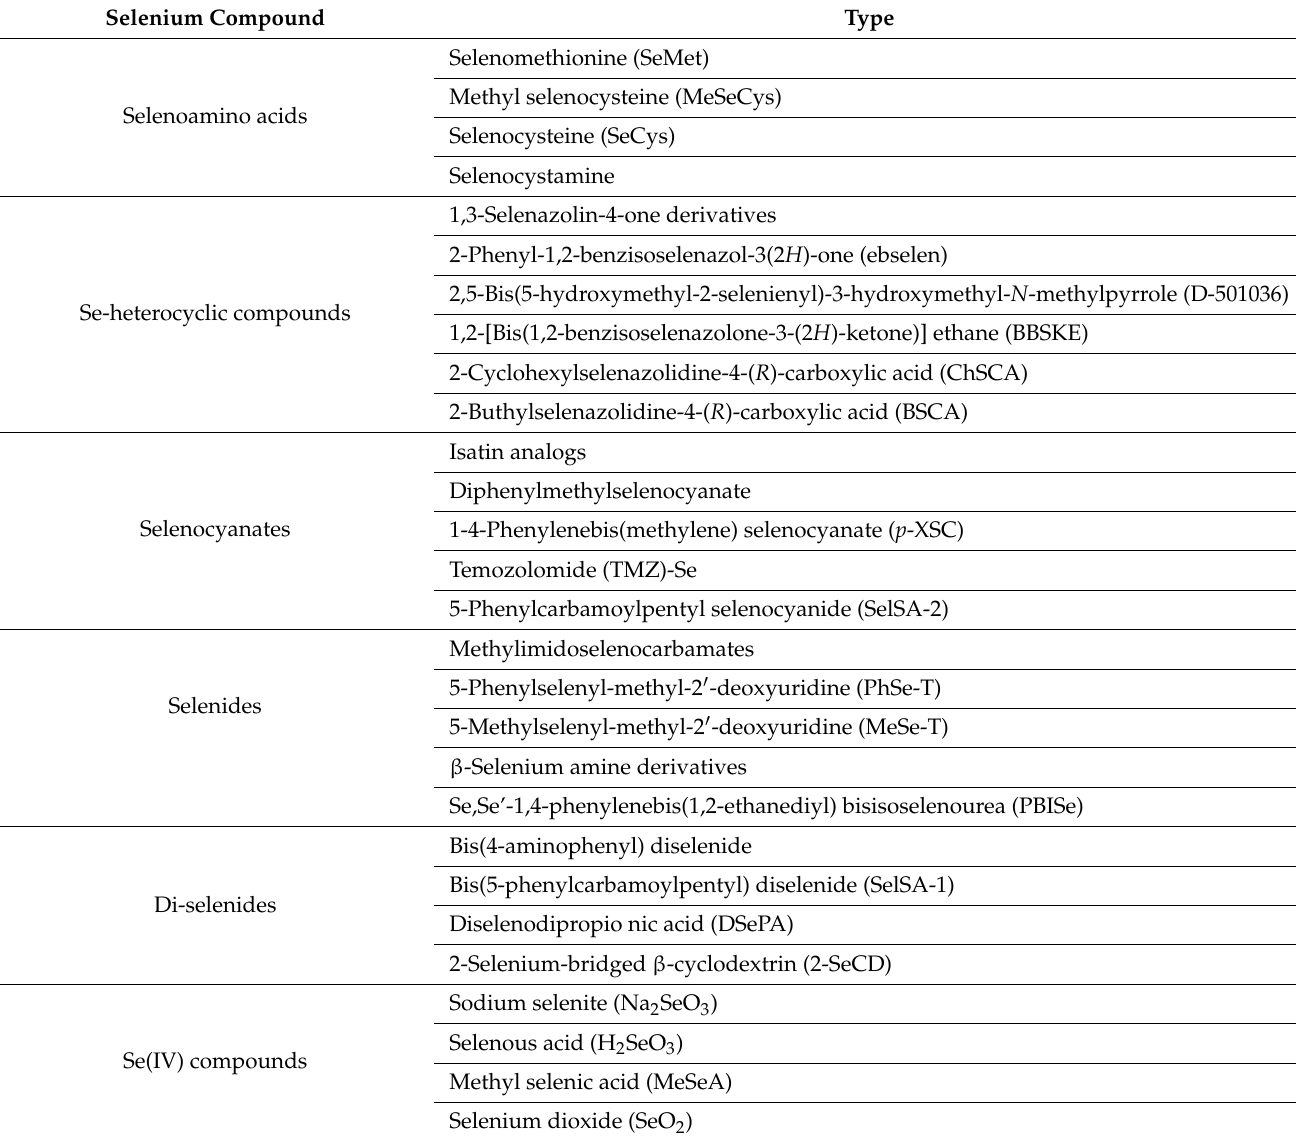
Table 1. Classification of selenium compounds based on structural features. Adapted from Ref. [79] under Creative Commons Attribution license. 2012, MDPI